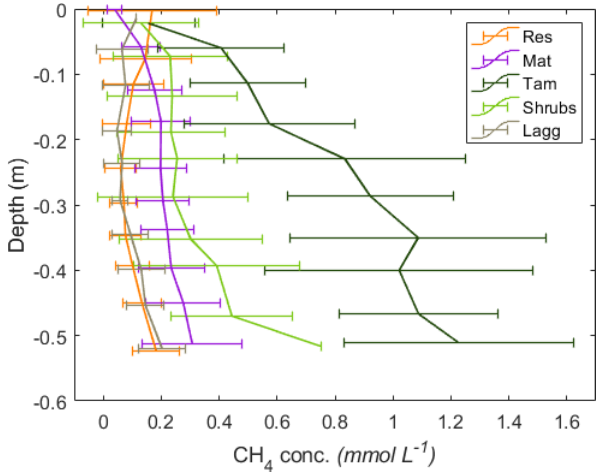
Figure 6. Vertical profiles of CH 4 pore-water concentrations by zone. The error bars represent the standard deviation of the monthly measurements for 2017 and 2018 combined. A minor y -axis jitter has been added to more clearly distinguish zone patterns. Note that the concentrations in the Tamarack zone at depth approach satura- tion (1.44mM at 20 ◦ C CH 4